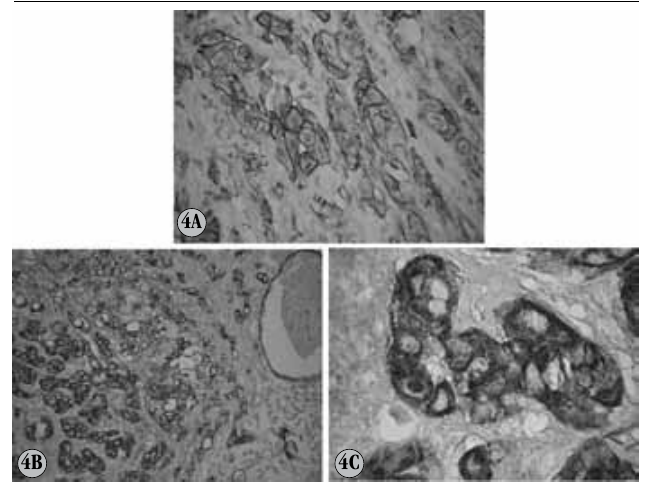
figurE 4 – HEE 4A) epithelioid cells displayed in nests, exhibiting membrane immunoexpression to CD31, endothelial marker (40×); 4B) diffuse neoplastic expression for CD34 antibody, endothelial marker (10×); 4C) neoplastic cells exhibiting immunoreactivity to Factor VIII, with clear cytoplasmic expression (100×) HEE: epithelioid hemangioendothelioma. Superficial and deep soft tissues represented the most affected topography (three cases; 23%), followed by head-neck (two cases; 15%), mediastinum (two cases; 15%), bone (two cases; 15%) and lung (two cases; 15%). Liver (one case; 8%) and lymph node (one case; 8%) were the other affected topographies